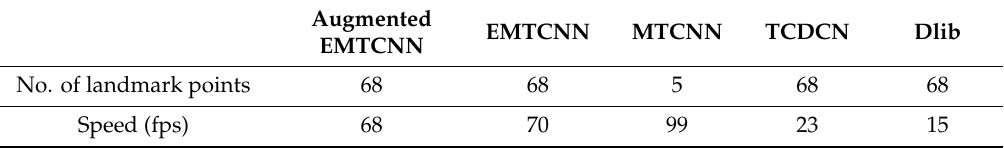
Table 4. Comparison of extraction speeds.